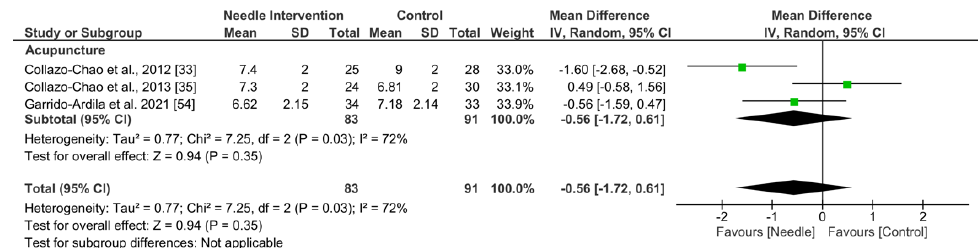
Figure 3. Forest plot for Pain Intensity: 3 to 6 months.